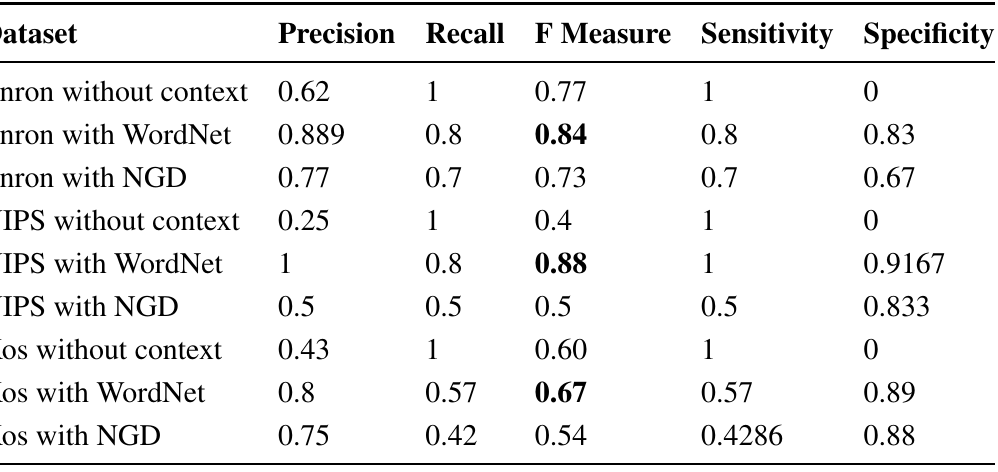
Table 2. Results on all the datasets with and without the addition of contextual information. Notice the increase in specificity (False Positive Rate = 1 − Specificity) and hence the decrease in false positive rate upon augmenting contextual information. The F